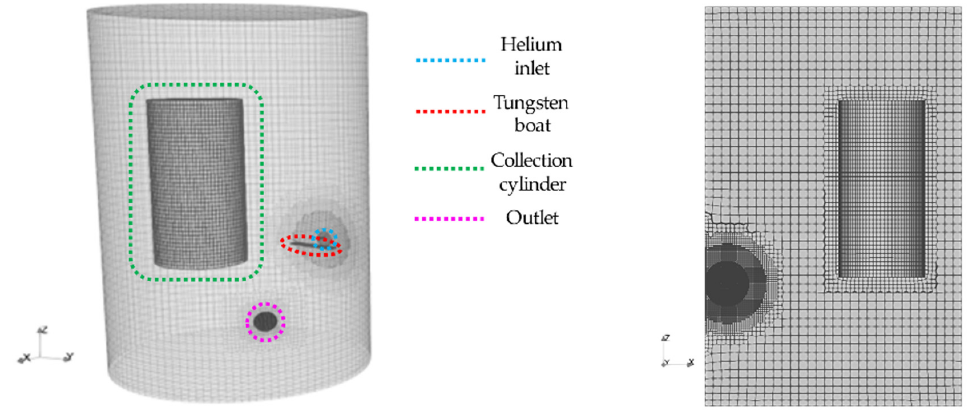
Figure 3. Simulated 3D geometry of the reactor, ( left ) frontal view and ( right ) xz-plane section.